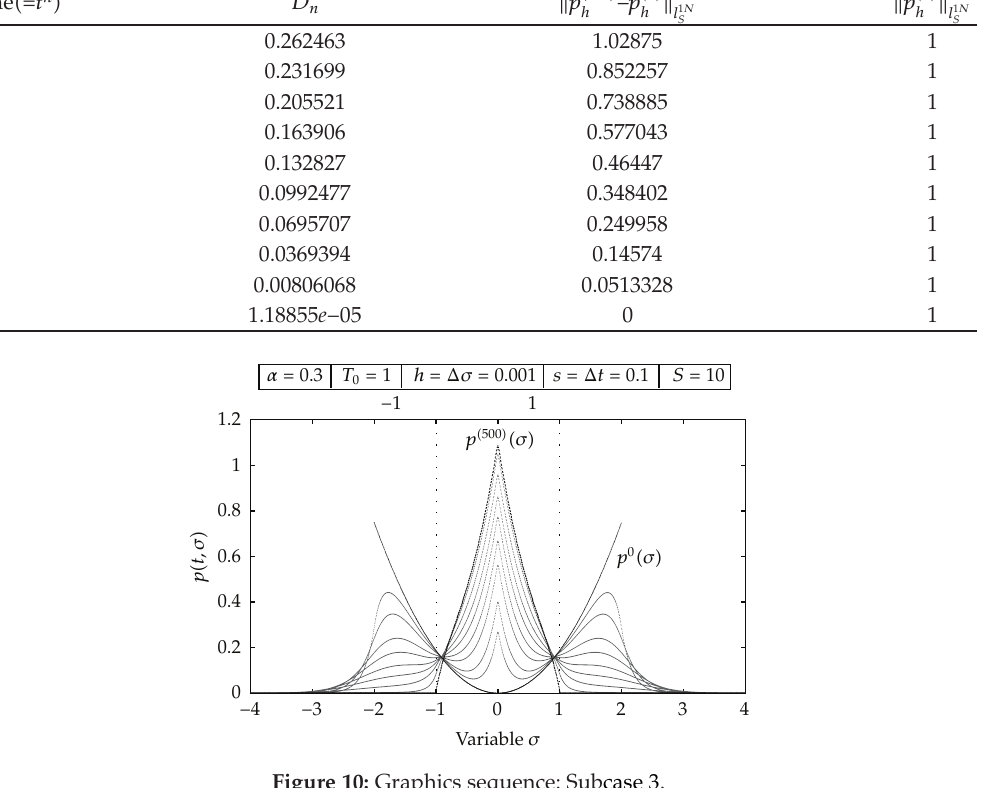
Figure 10: Graphics sequence: Subcase